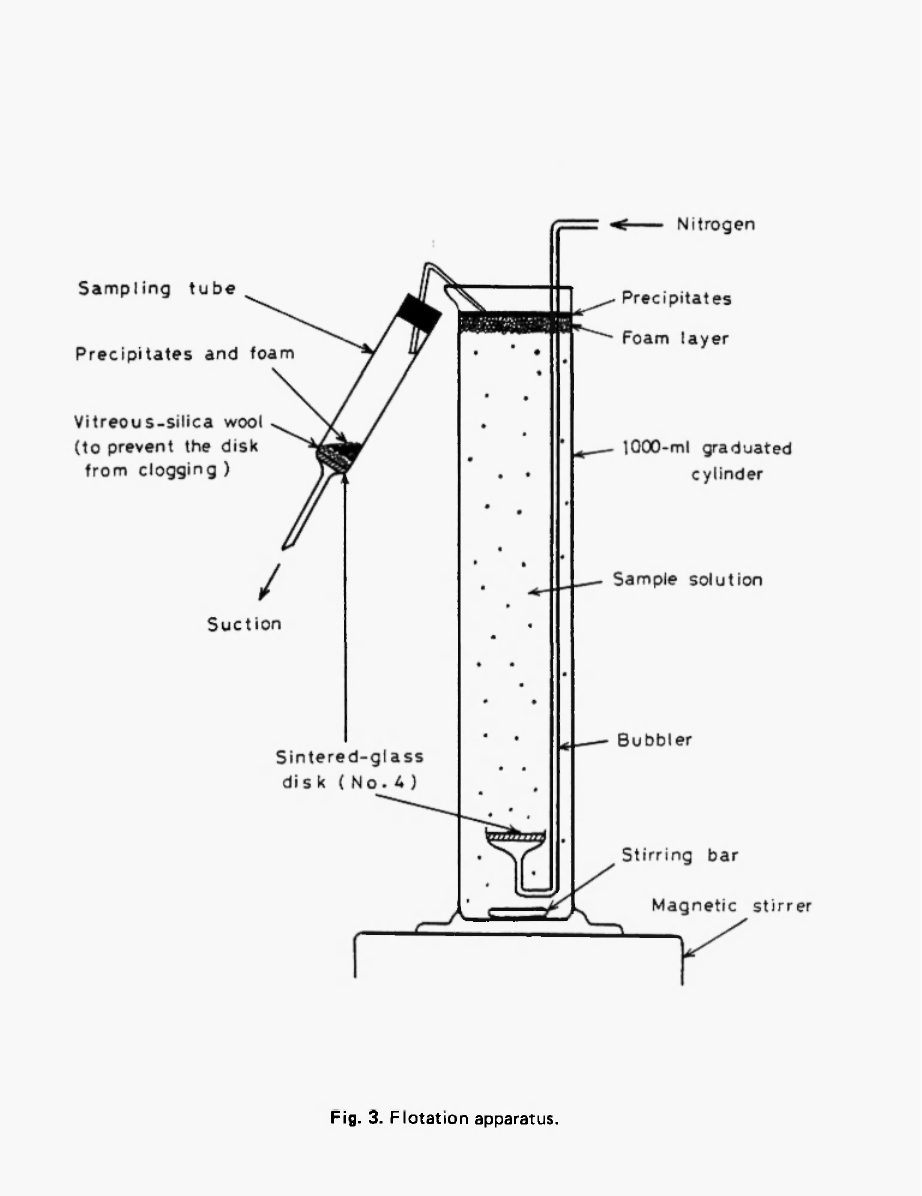
Fig. 3. Flotation